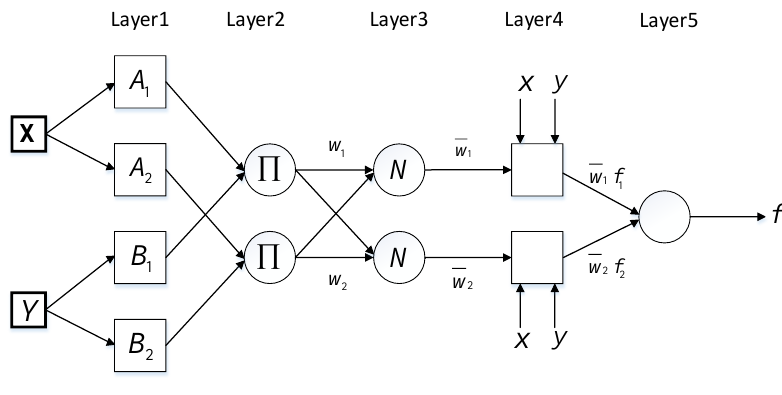
Figure 3. Schematic diagram of ANFIS.